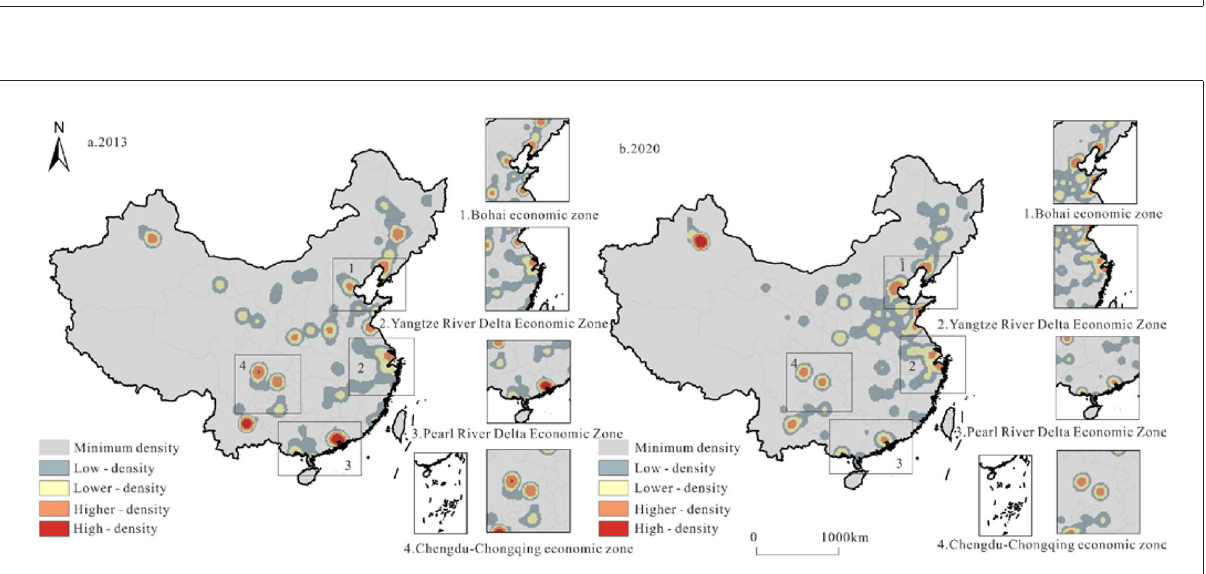
FIGURE3 Evolution of the total scale of railway container transport in